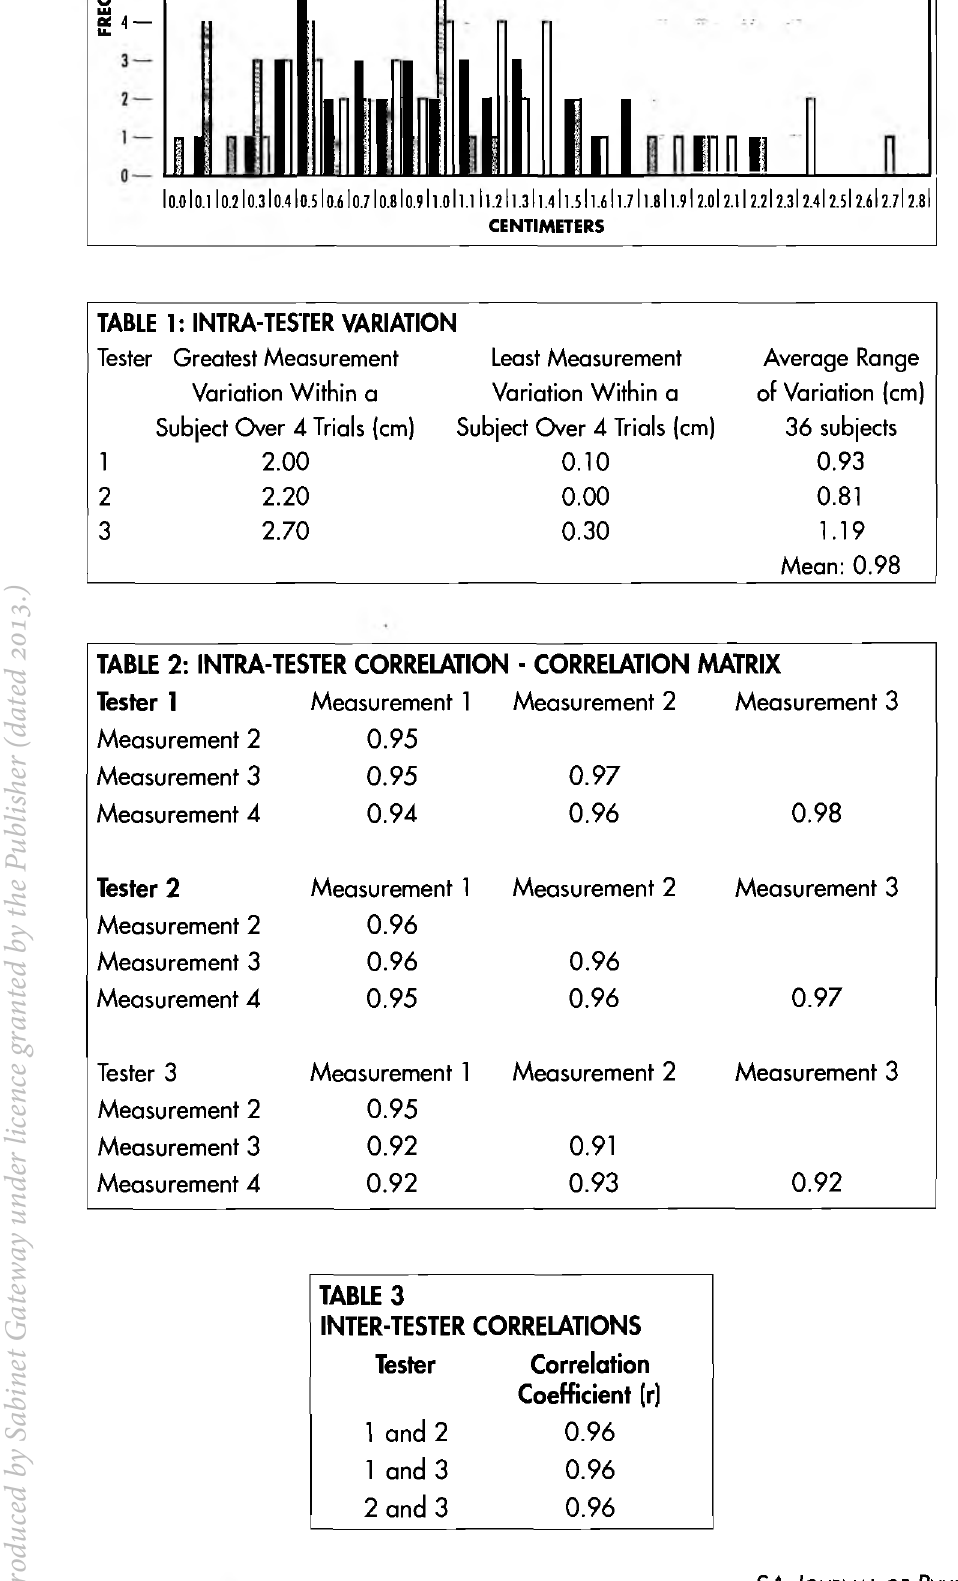
TABLE 1: INTRA-TESTER VARIATION